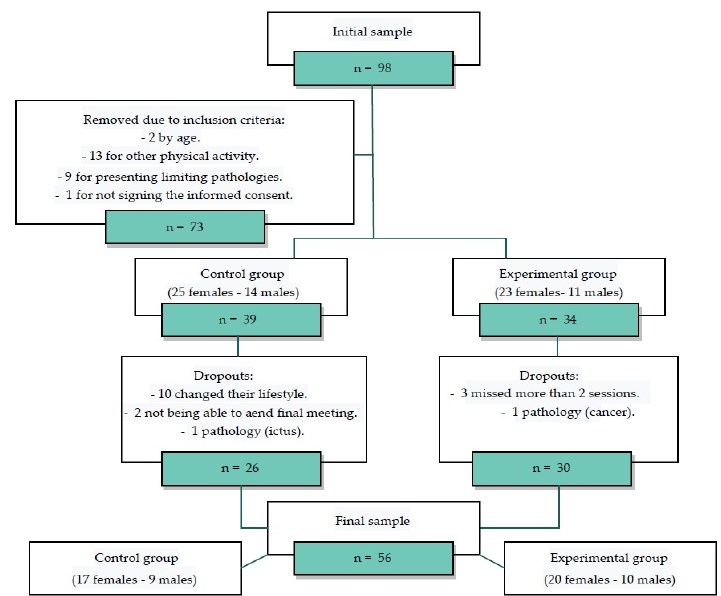
Figure 1. Sample selection flowchart.